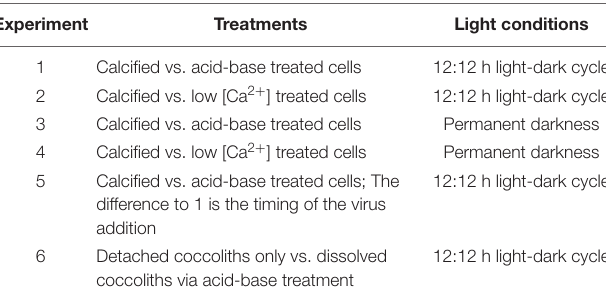
TABLE 1 | Overview of the